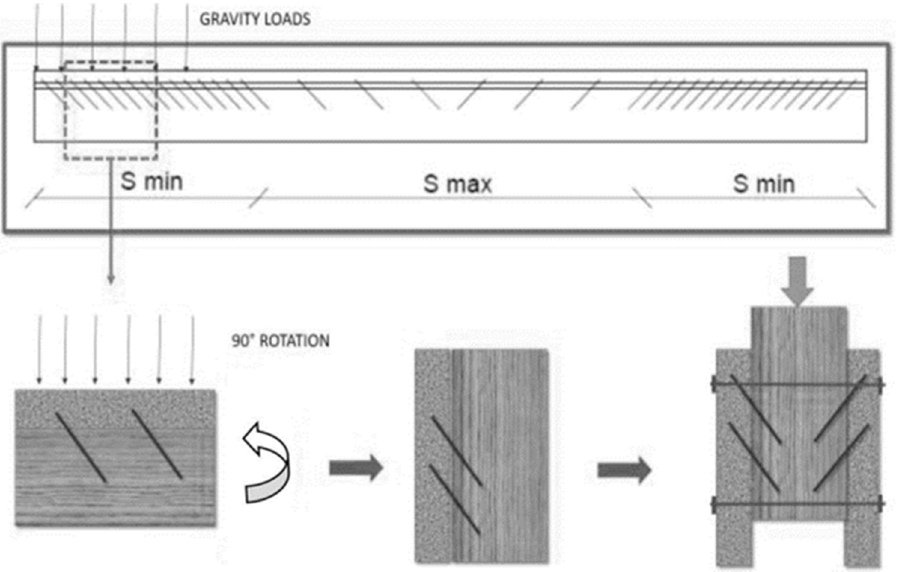
Figure 2. Conventional experimental procedure for the mechanical characterization of TTC joints with inclined STSs.